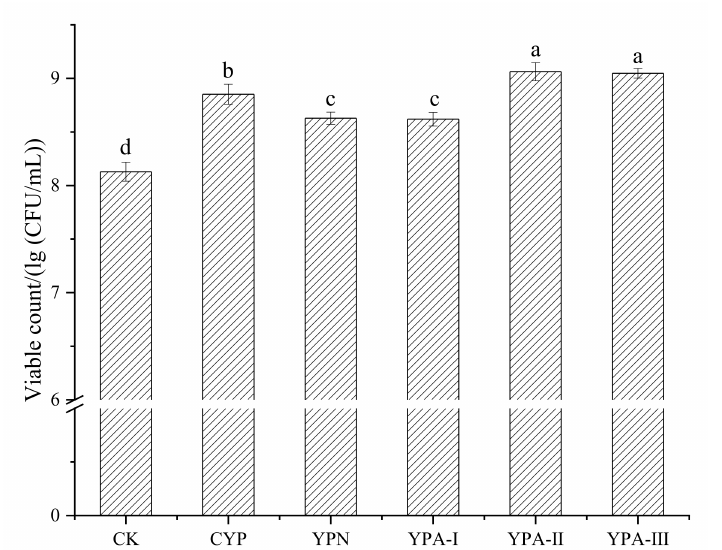
Figure 1. DEAE-cellulose 52 elution curve of CYP.